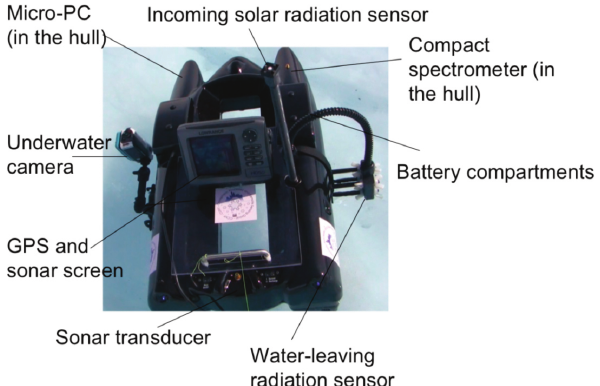
Fig. 1. The customized remotely controlled boat with the different